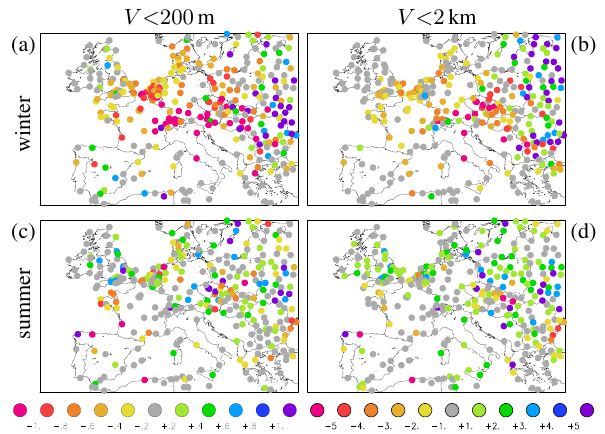
Fig. 12. The regression of the number of dense fog (a) and (c) , and mist (b) and (d) days on zonal geostrophic wind A U [dym − 1 s], in winter (a) and (b), and summer (c) and (d).